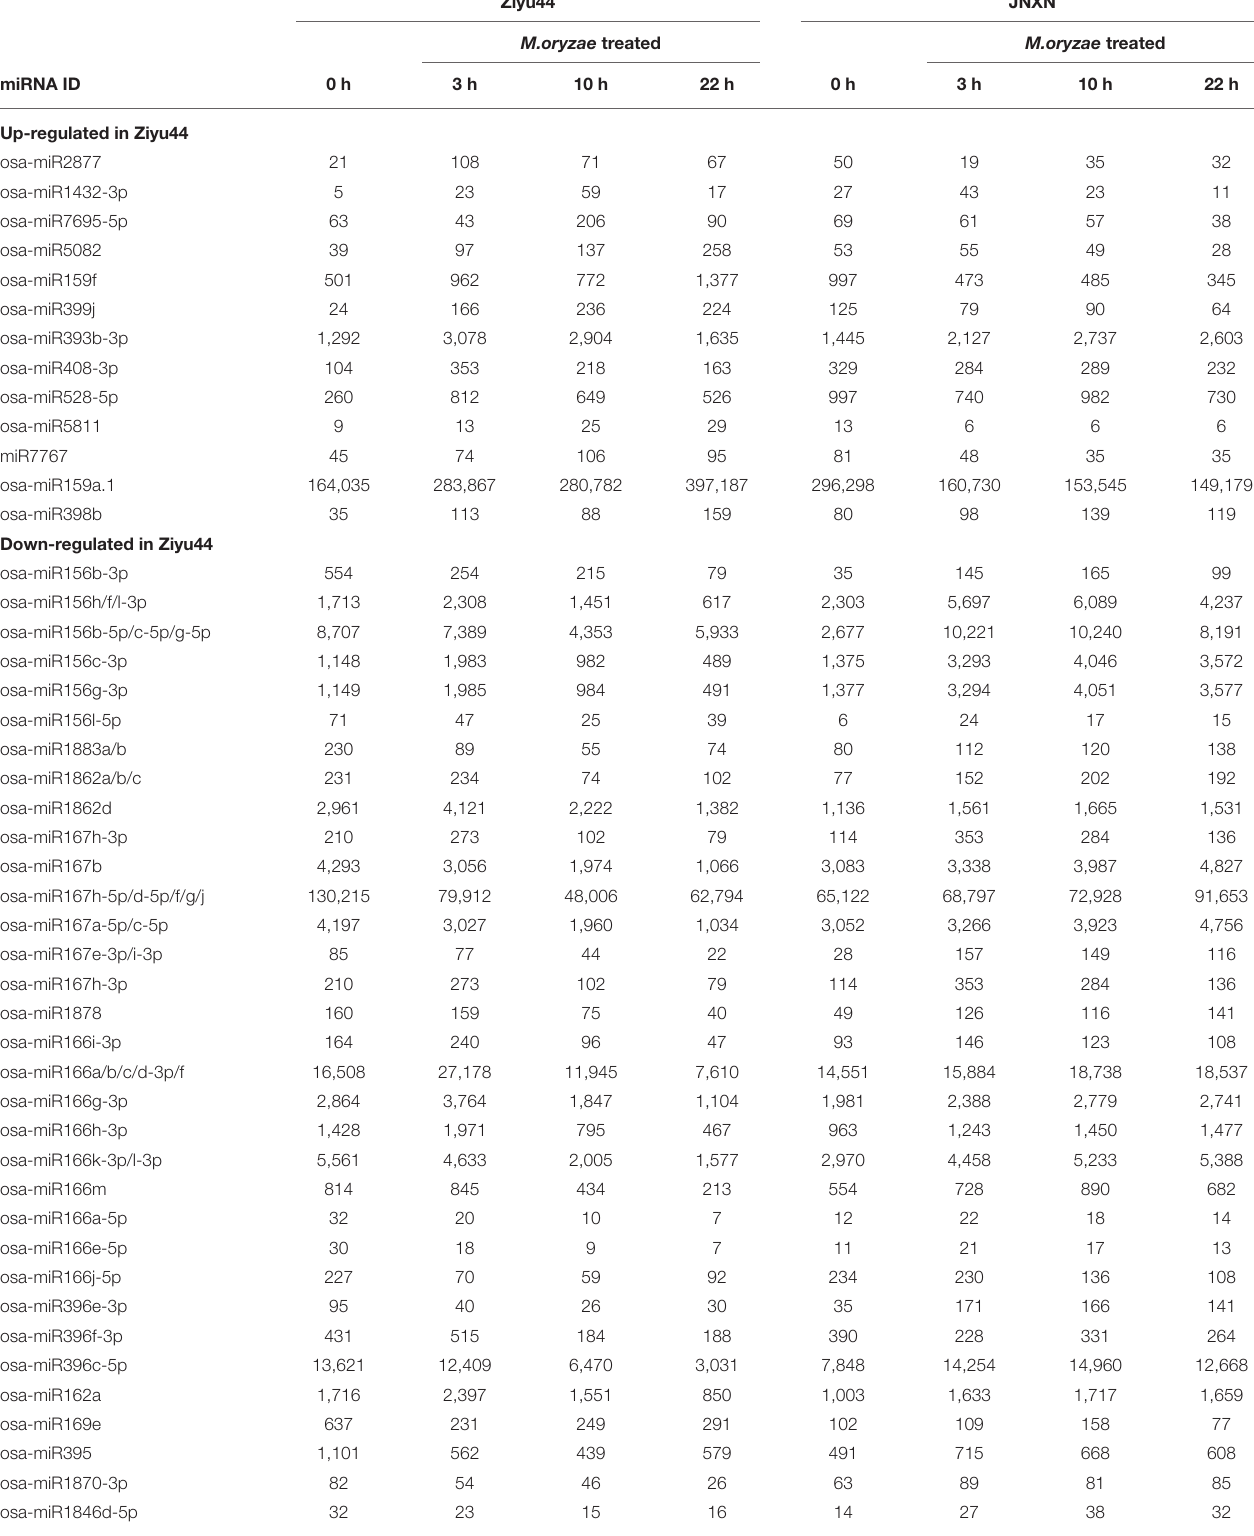
TABLE 1 | Identified miRNAs with significant differential expression in Ziyu44.